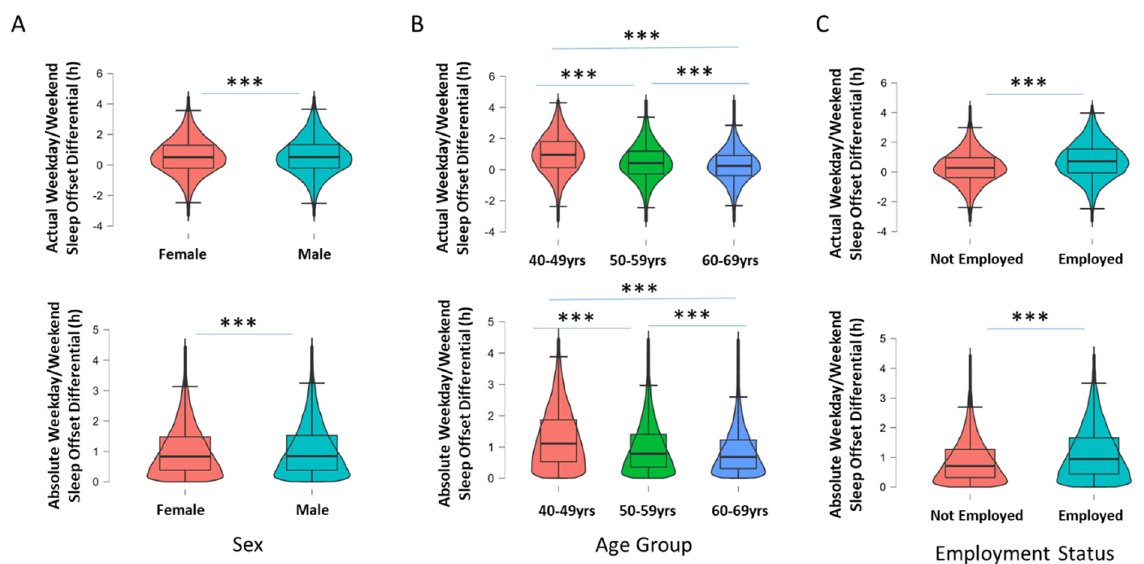
Figure 2. Box-and-violin plots showing ( A ) actual and absolute WD/WE in males and females; ( B ) actual and absolute WD/WE according to three age groups of participants (40 to 49 years old, 50 to 59 years old and 60 to 69 years old); and ( C ) actual and absolute WD/WE in participants currently in employment and currently not in employment. *** denotes p < 0.001 for pairwise comparisons (Tukey post hoc test following p < 0.001 for one-way ANOVA for age groups).